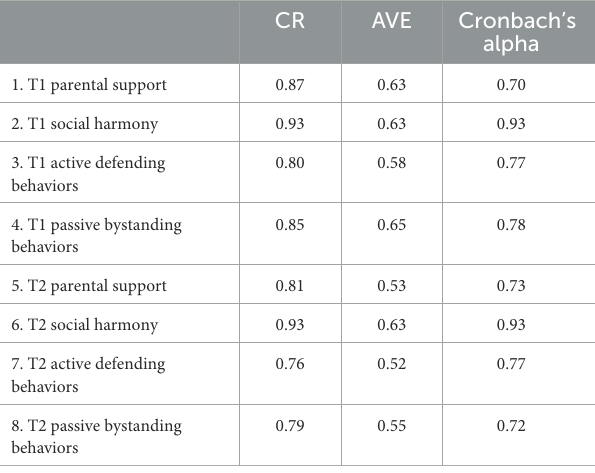
TABLE 2 Reliability results and AVE results of